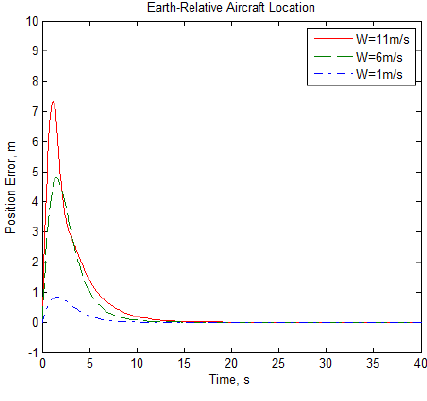
Figure 6: Airplane states in presence of wind